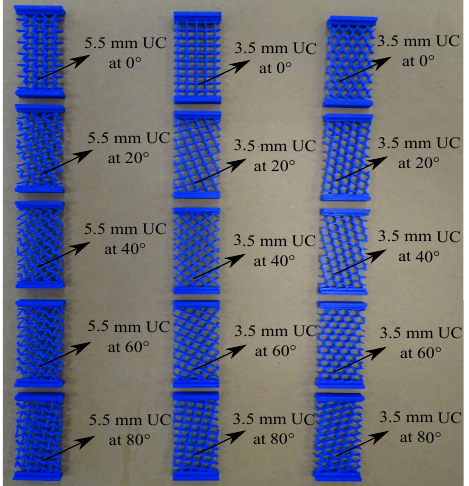
Figure 9. Types of lattice-flexure hinges used for the lattice-compliant cross-axis joint.